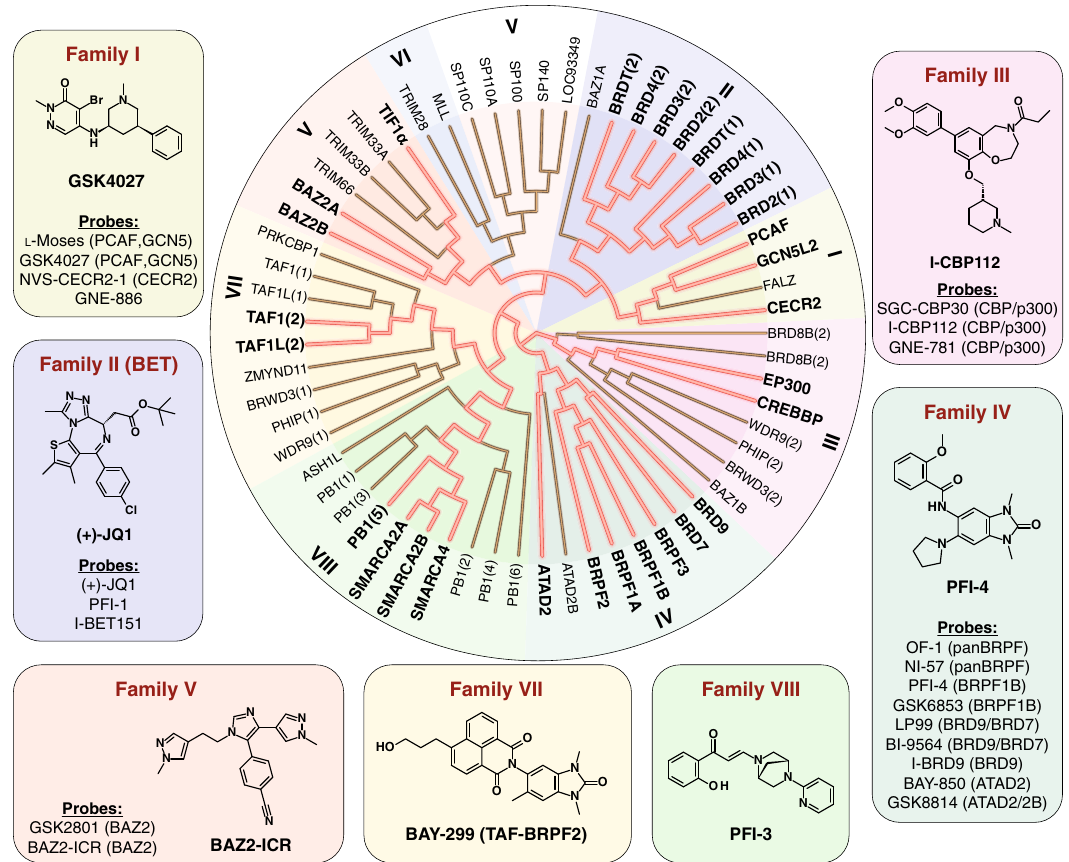
Fig. 1 Chemical probes of the human bromodomain family. The set includes probes developed by our laboratory and a selection of additional inhibitors that are available. For each BRD family a single structural example of a chemical probe is shown. Additional probes are listed and a summary showing all chemical structures is included in Supplementary Table 1. BRD family members for which probes have been developed are highlighted in bold and by dark red lines in the